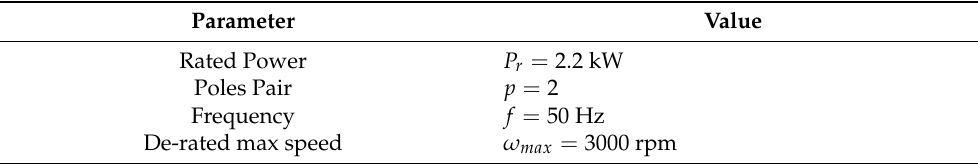
Figure 5. Detailed angled view of seal test bench section of the test rig.